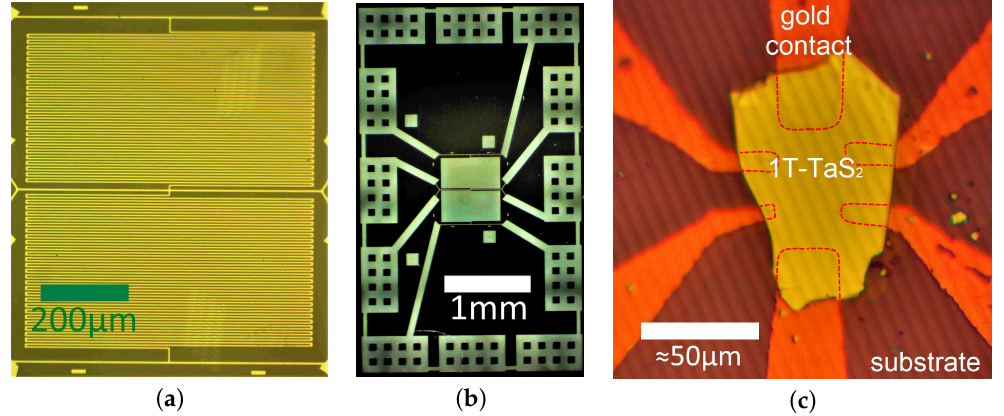
Figure 5. Implementations of the micromask lithography. ( a ) A meander-shaped Al structure on a silicon substrate made by the micromask lithography and the lift-off process; the width of the depicted structure is 850 µ m, the thickness of the neighbouring lines and the distance between them are 4 µ m. ( b ) Dark-field image of the shadow mask used to produce the meander and contact pads for it; the width of the structure is ≈ 4 mm. ( c ) A microflake of the electrically switchable material 1T-TaS 2 placed on the micromask-fabricated contact electrodes using the transfer